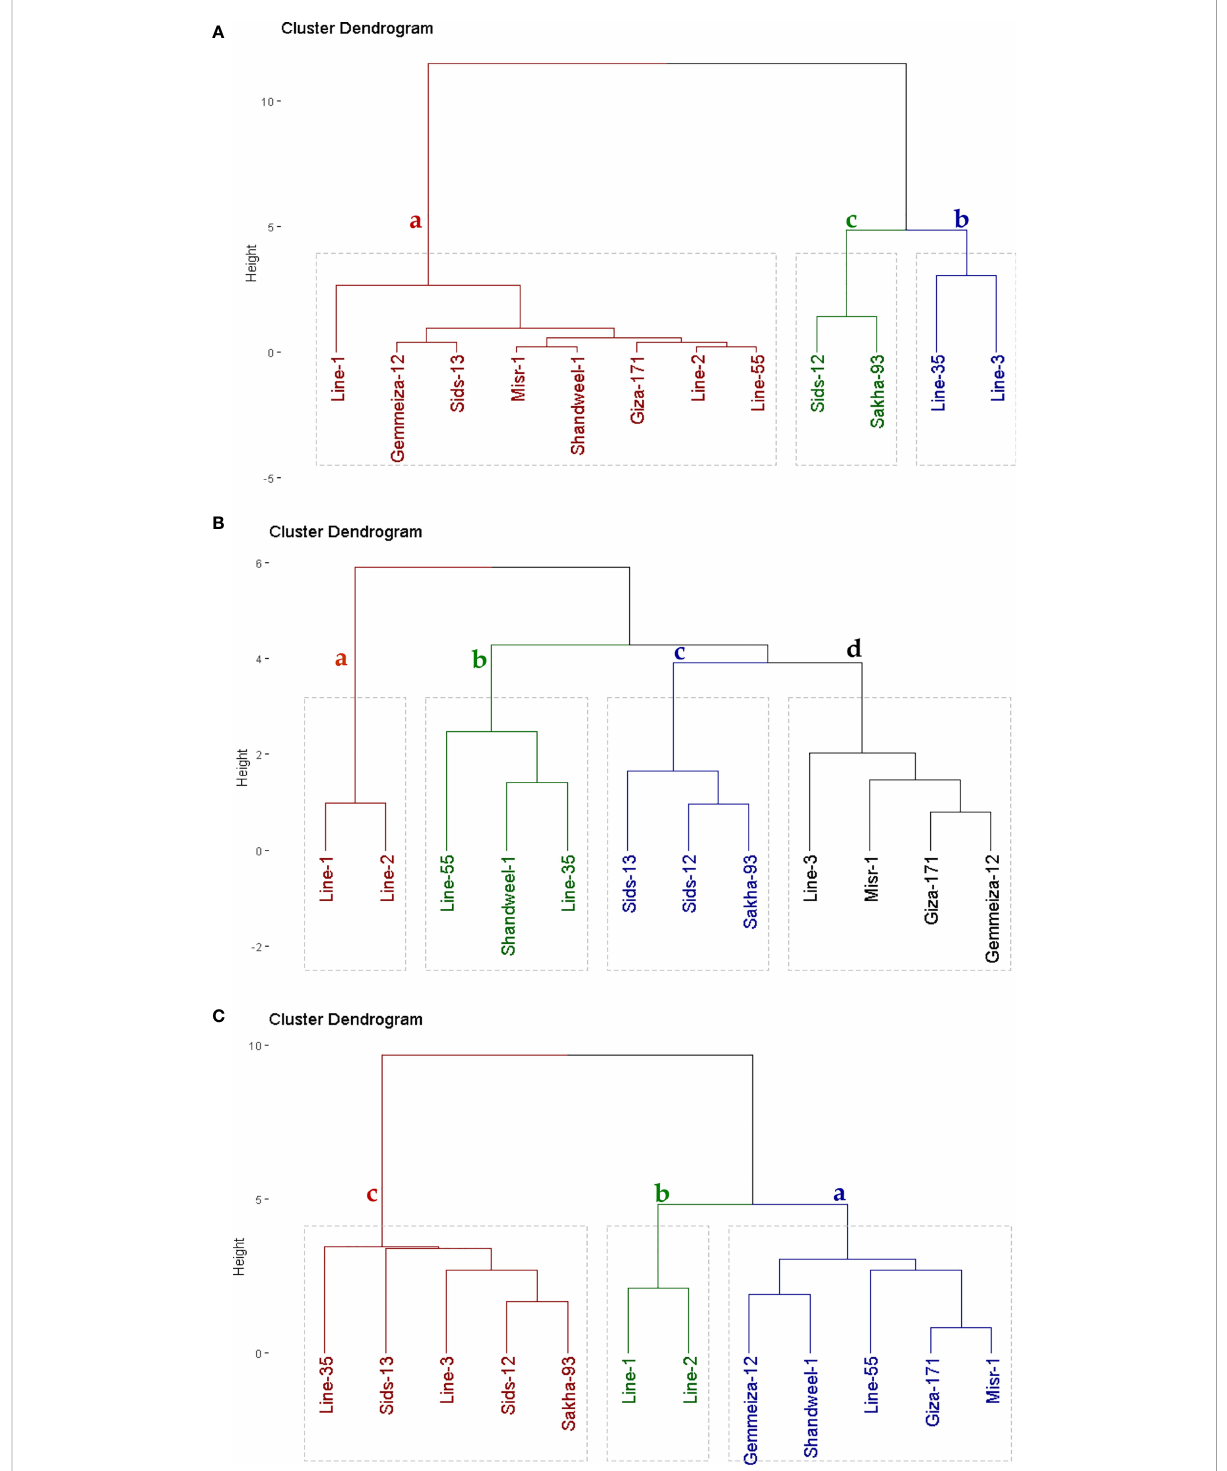
FIGURE 2 Dendrogram of the phenotypic distances among twelve bread wheat genotypes based on the yellow rust measurements (A) , heat tolerance indices (B) , and yield traits (C) in eight